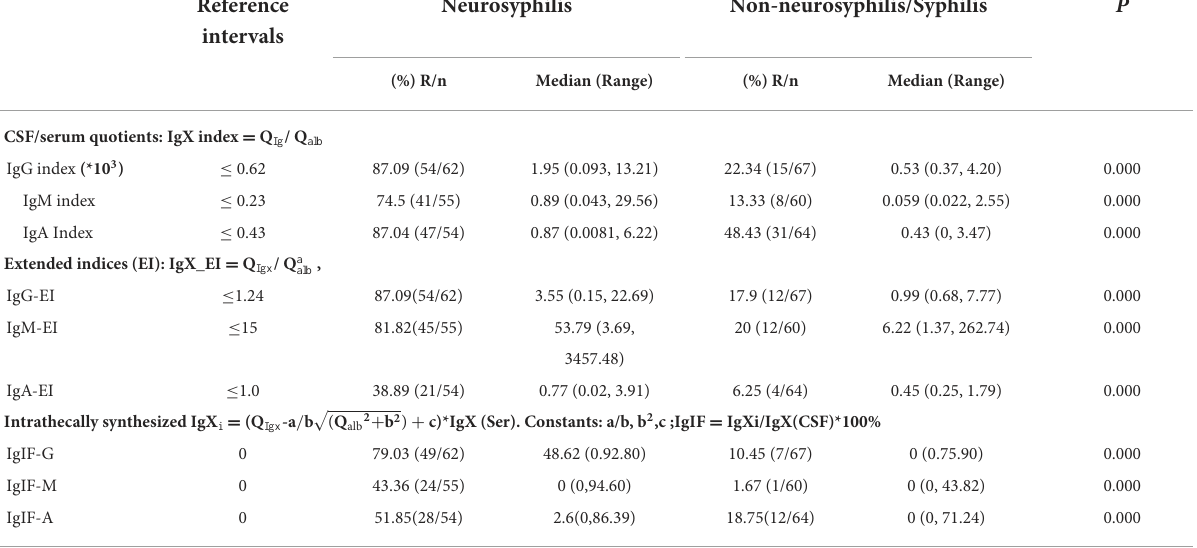
TABLE 2 Quantitative assessment of Intrathecal immunoglobulin synthesis by different